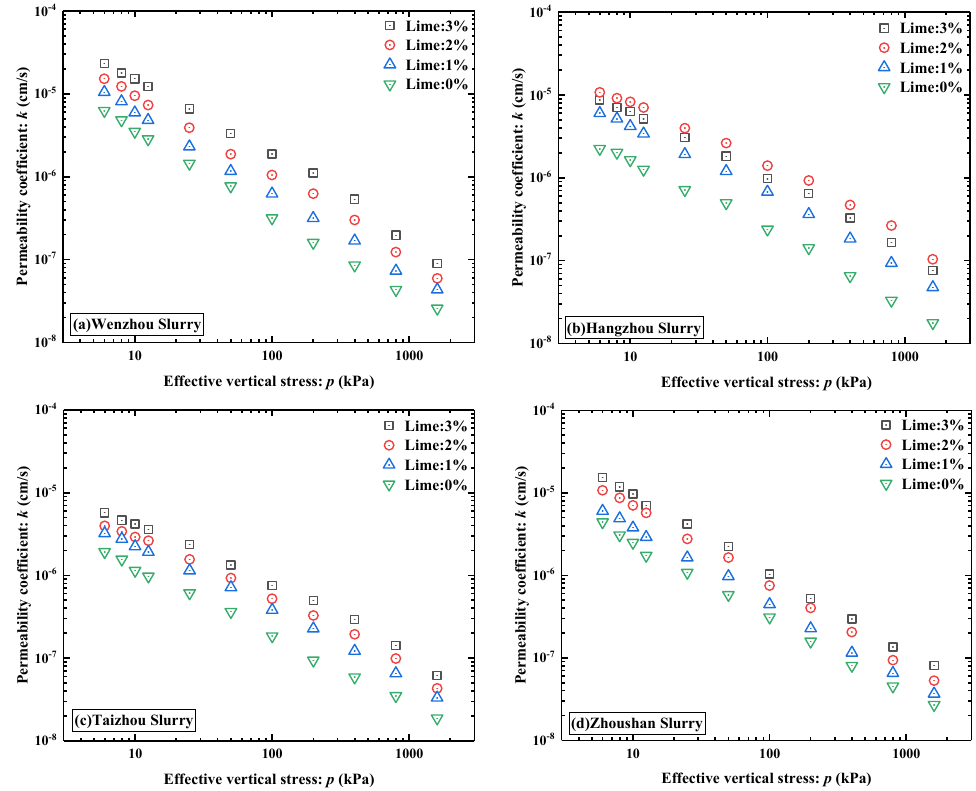
Figure 5. Slurry log k –log p curves for each group with different lime dosages. ( a ) Wenzhou soil sample, ( b ) Hangzhou soil sample, ( c ) Taizhou soil sample, ( d ) Zhoushan soil sample.